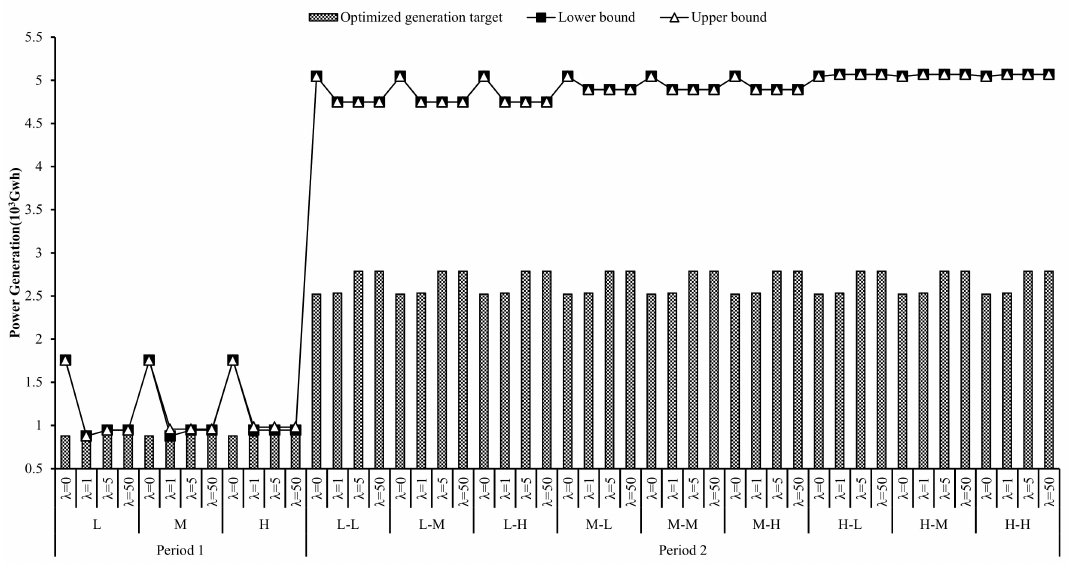
Figure 5. Optimized biomass power generation amount in the planning